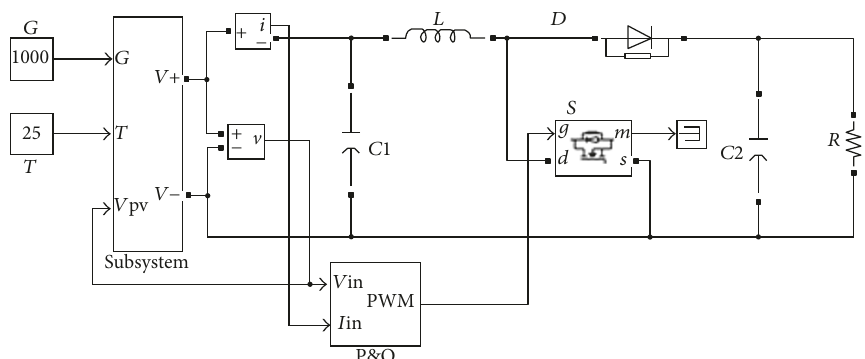
Figure 8: Model of fuzzy MPPT control.